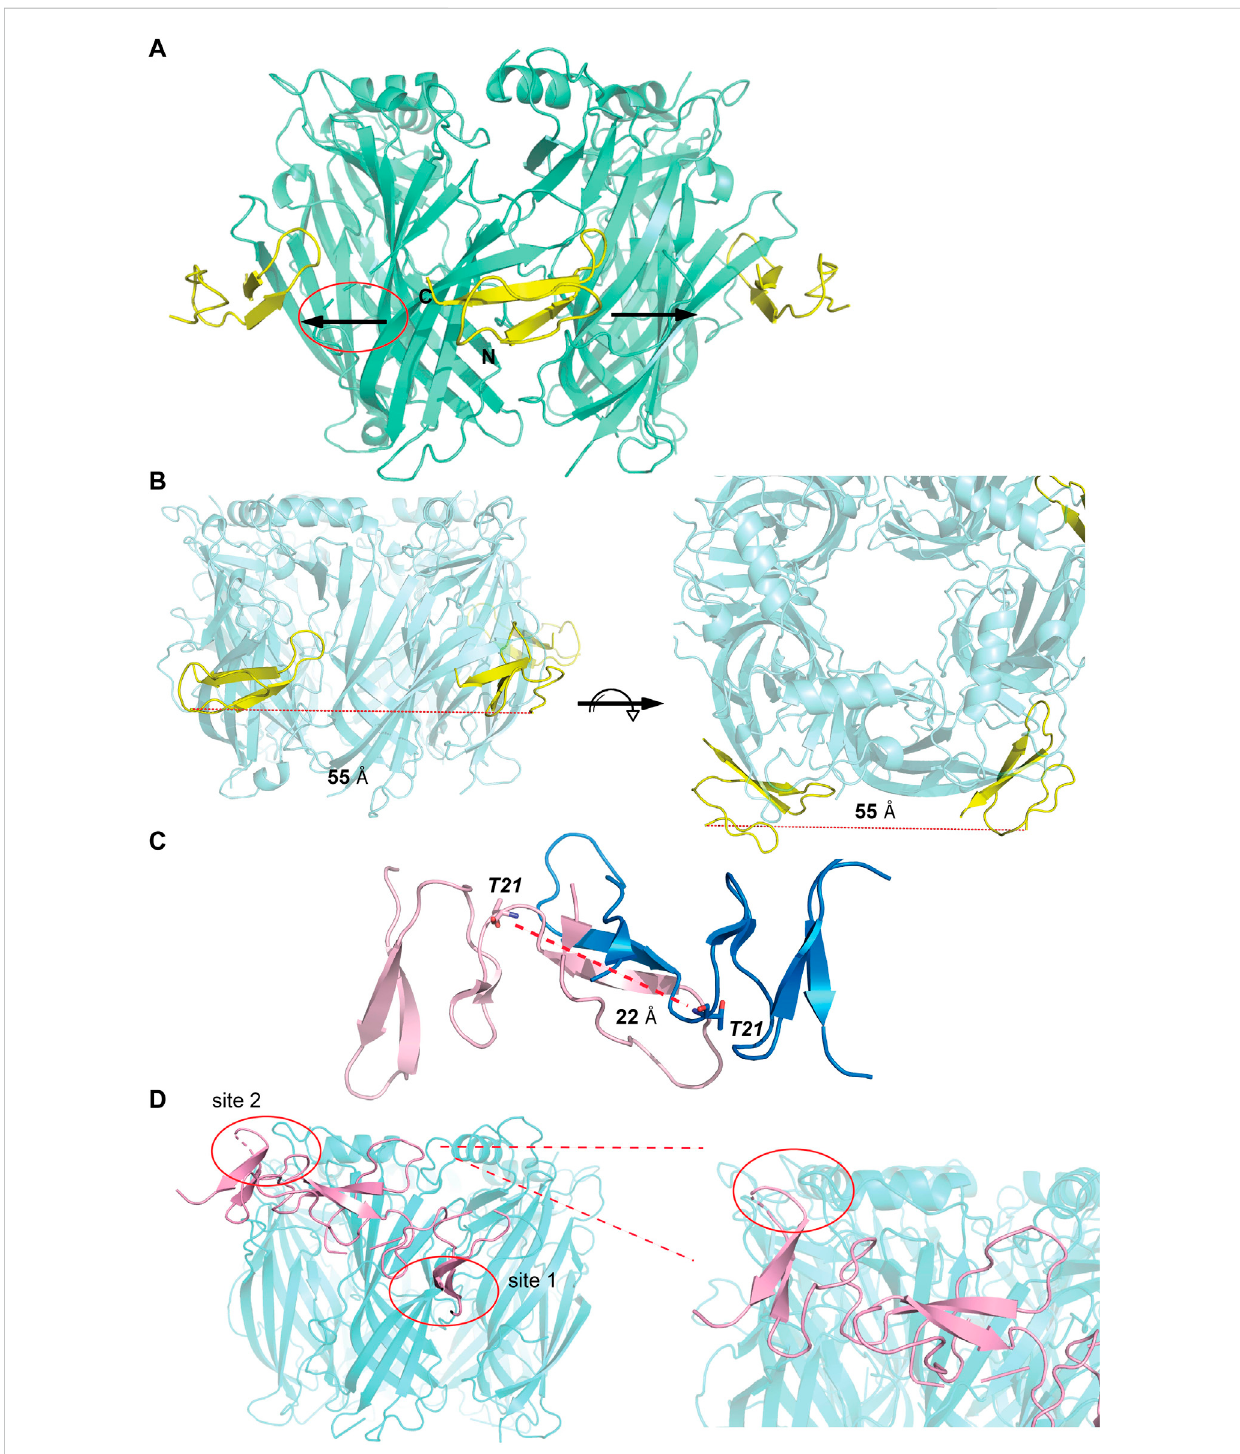
FIGURE 7 PotentialbindingmodeofhomodimericVxXXB. (A) AclockwiseorientationwasproposedforVxXXBifoccupyingtwoadjacentbindingsites. (B) Side and top view of the Ls -AChBP/ α D-VxXXB-C (21 – 50) co-crystal structure. The distance between two adjacent α D-VxXXB-CTDs is 55 Å assuming a linear approach. (C) The distance between two ends of α D-VxXXB-CTD (as measured between Thr21 from each end) is 22 Å. (D) The docking result of homodimeric VxXXB model built from the crystal structure of GeXXA at Ls -AChBP is displayed. Docking was performed using the HADDOCK webserver and residues found in the interactions between α D-VxXXB-C (21 – 50) and Ls -AChBP were used as constraints. The second CTD interacting with binding site 2 is circled and Ls -AchBP_Asp5, equivalent to rat α 10_His7 that interacted with GeXXA, is shown in stick